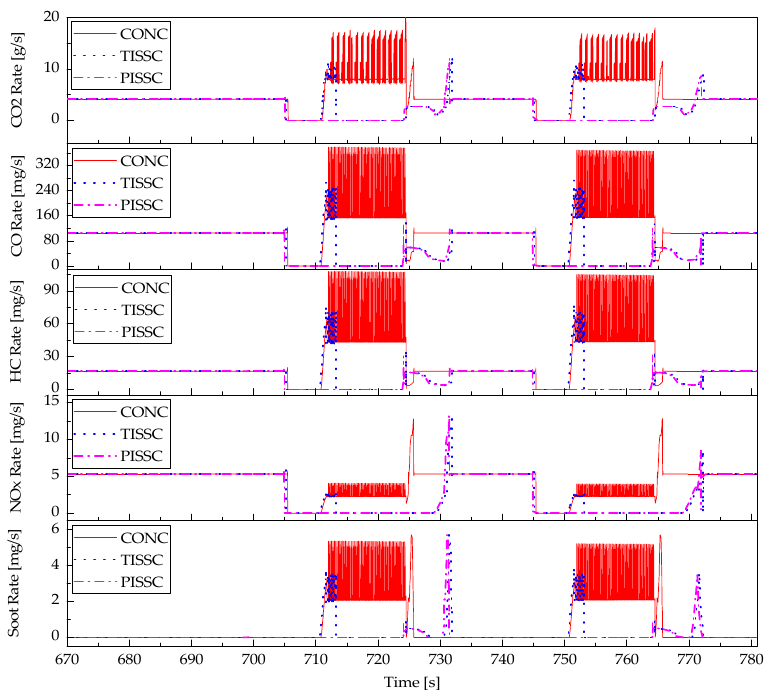
Figure 18. Comparison of HIL-ICE emission rates using difference controllers during cycle 7th.